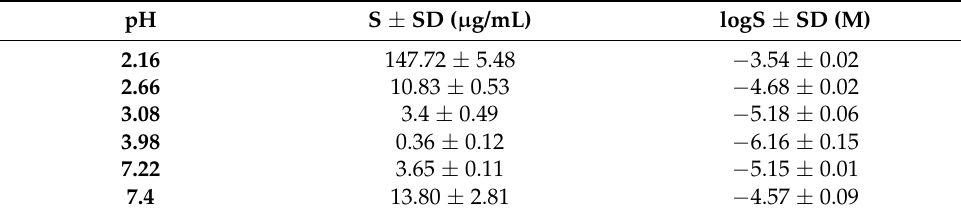
Table 3. Equilibrium solubility of Telmisartan in distilled water. pH